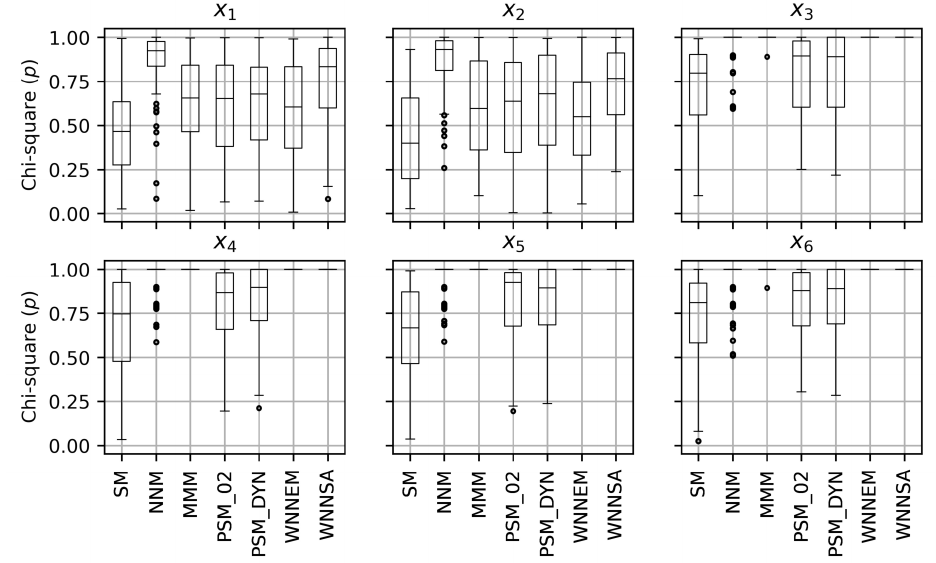
Figure 4. Similarities of the case and control groups on ordinal and binary attributes in Scenario II. Distributions of the Chi-square p -values calculated for ordinal ( x 1 , x 2 ) and binary ( x 3 , x 4 , x 5 , x 6 ) covariates separately, based on all simulations in Scenario